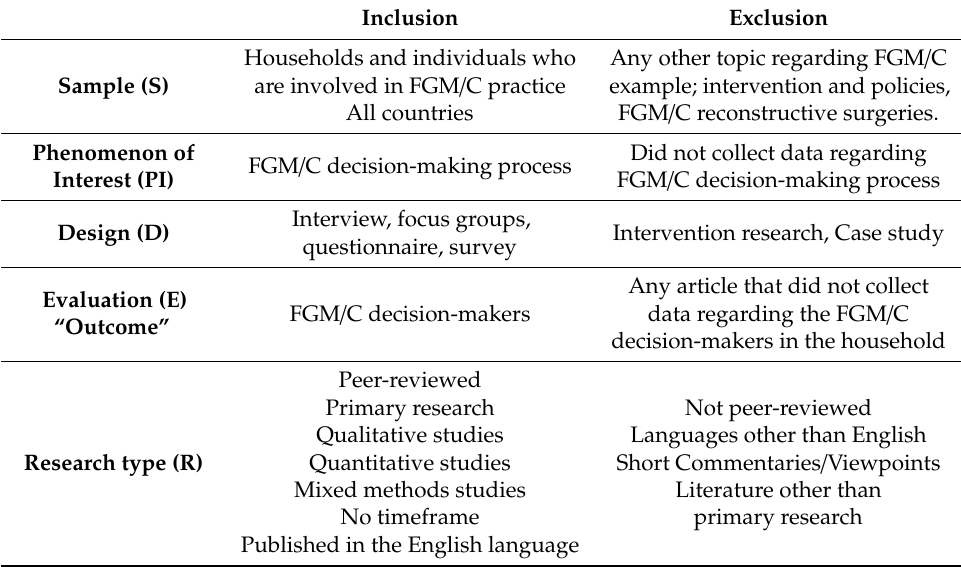
Table 2. Inclusion and exclusion